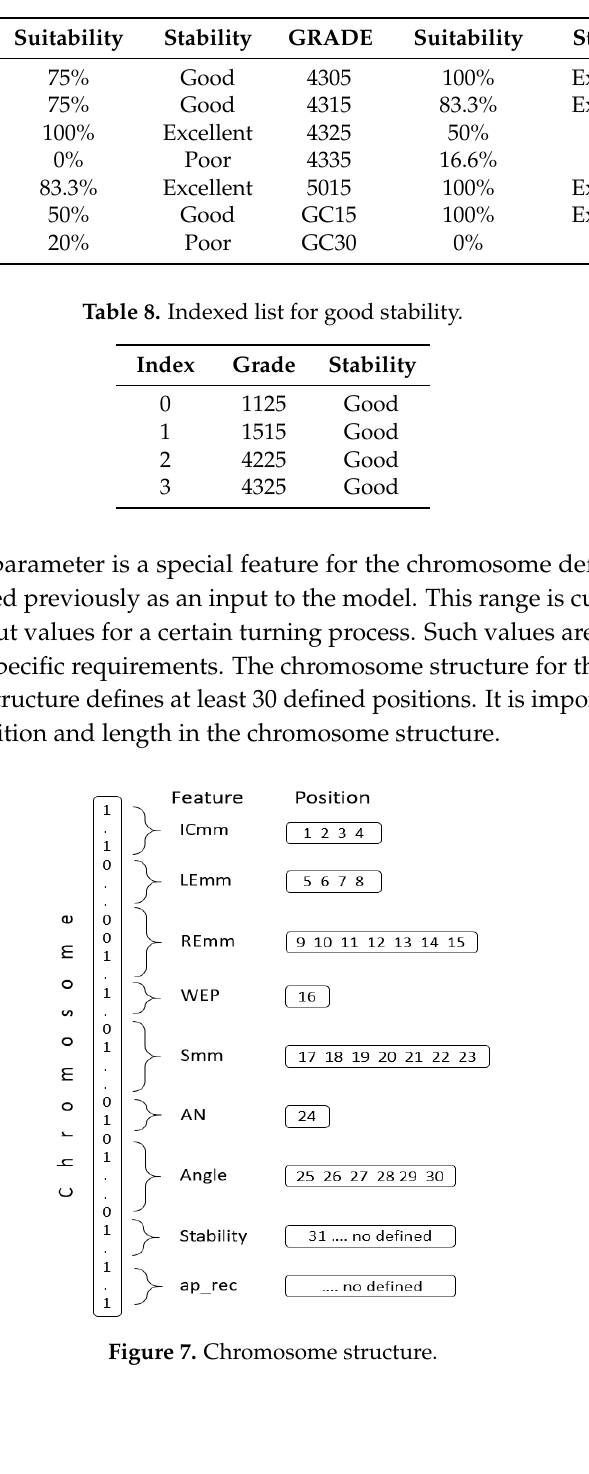
Table 7. Grade stability.